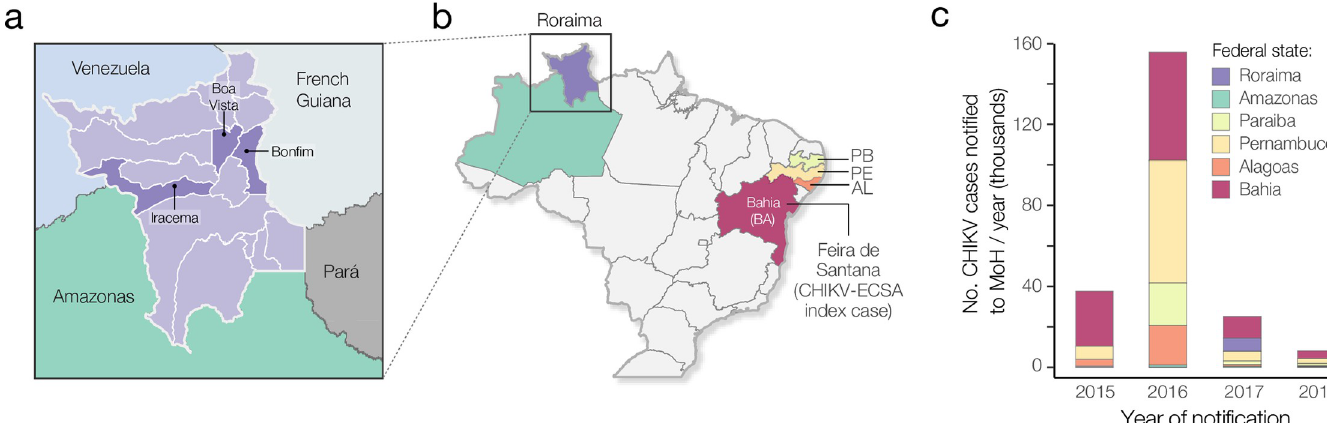
Fig 1. Context of this study. A. Map showing municipalities of Roraima state, including Boa Vista, bordering countries (Venezuela and French Guiana) and bordering Brazilian federal states (Amazonas and Para´). B. Map of Brazilian states, showing the states from which CHIKV sequence data in this study was analysed (Bahia, Alagoas, Pernambuco, Paraı´ba, Amazonas and Roraima). C. Barplot showing the annual number of notified CHIKV cases in selected states of Brazil (data obtained from the Brazilian Ministry of Health). Map was made with Natural Earth. Free vector and raster map data at naturalearthdata.com.